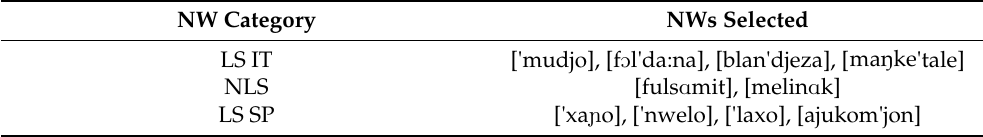
Table A1. Overview of NWs selected for the Spanish–Italian NWRT.